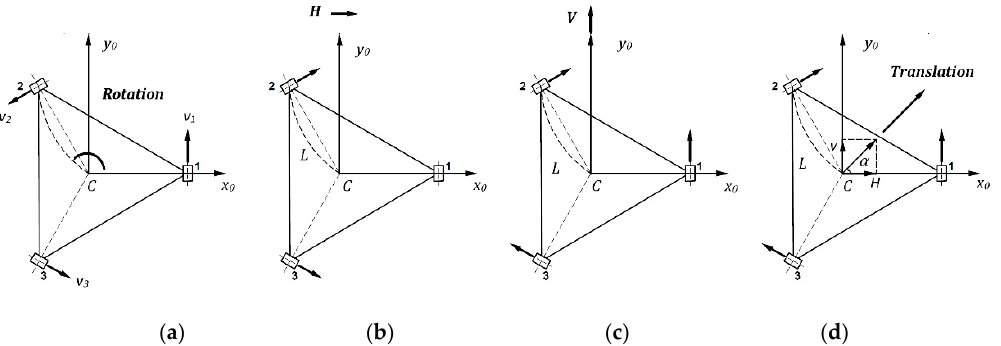
Figure 3. Three moving modes of omnidirectional wheeled wheelchair, ( a ) Rotational moving, ( b ) Horizontal moving, ( c ) Vertical moving, and ( d ) A translation moving is a vector sum of V and H. For the first case, the pure rotational motion is attained when ω C (cid:44) 0 and H = V =